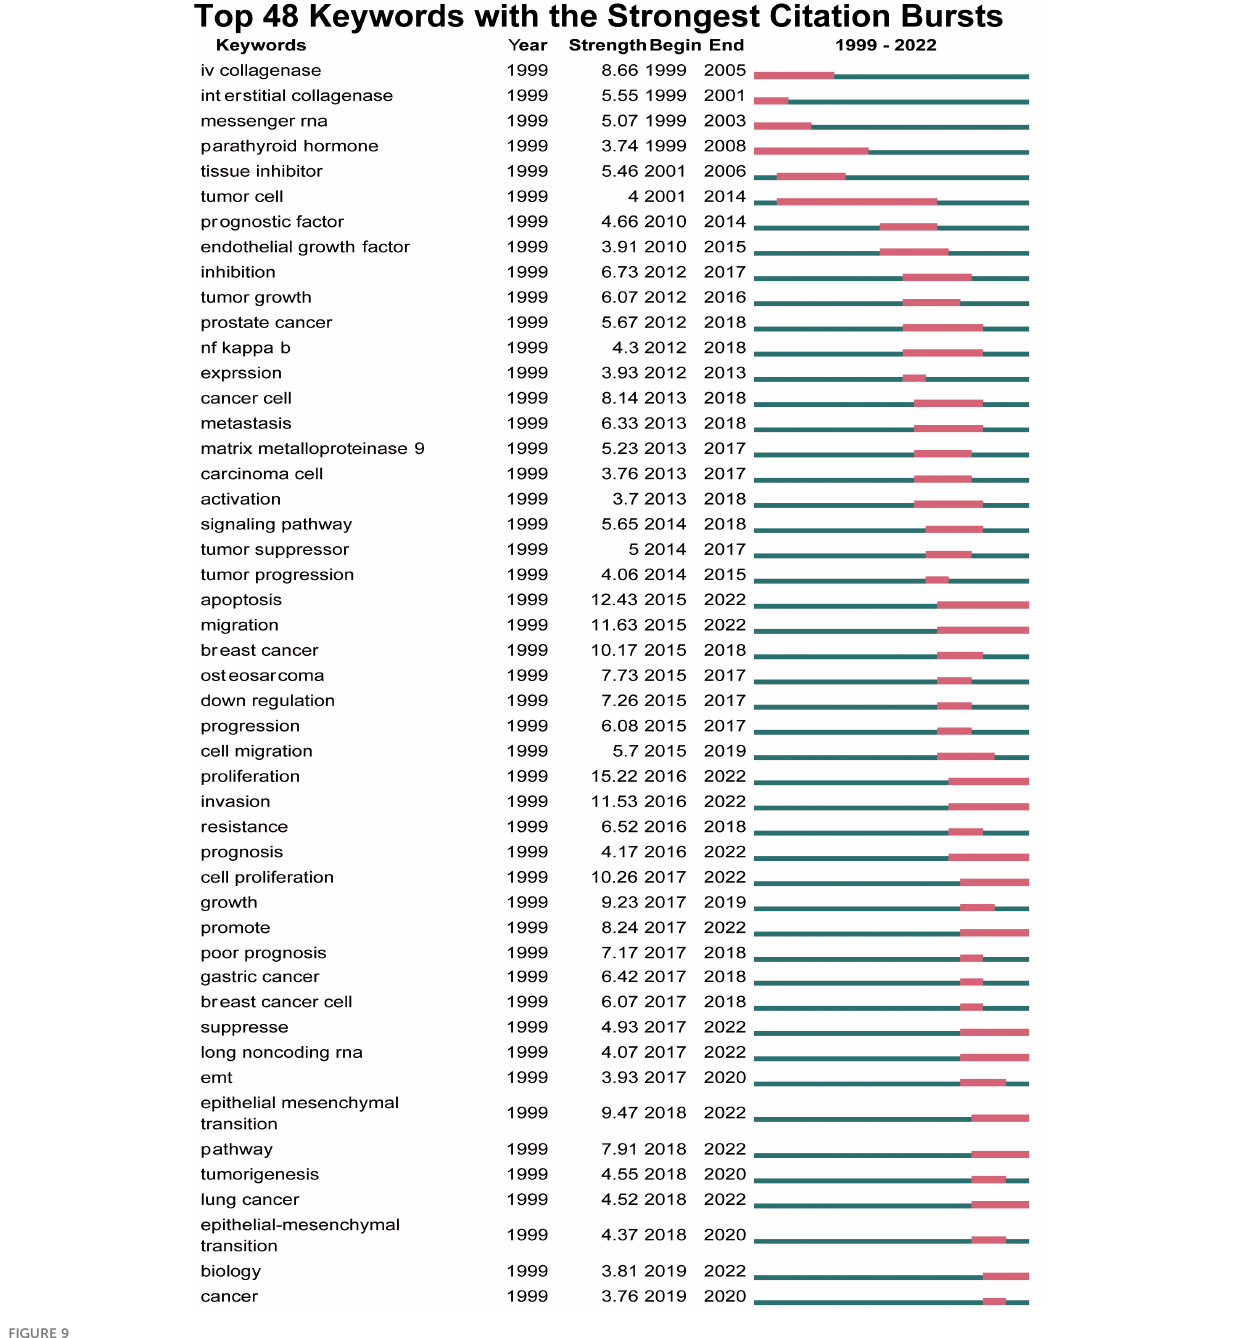
FIGURE 9 Keywords with strongest citation burst ’ s view of MMP-OS